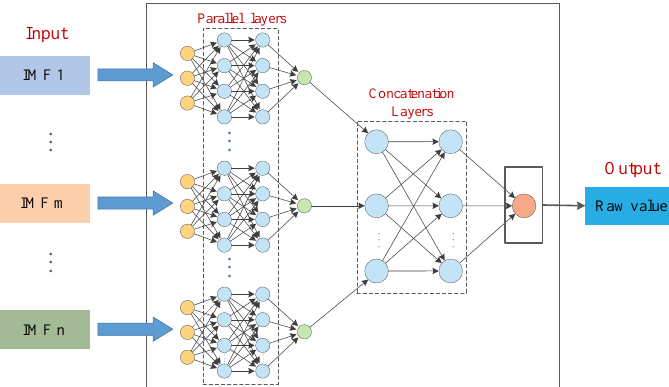
Figure 3. Structure of the constructed parallel-input neural network.